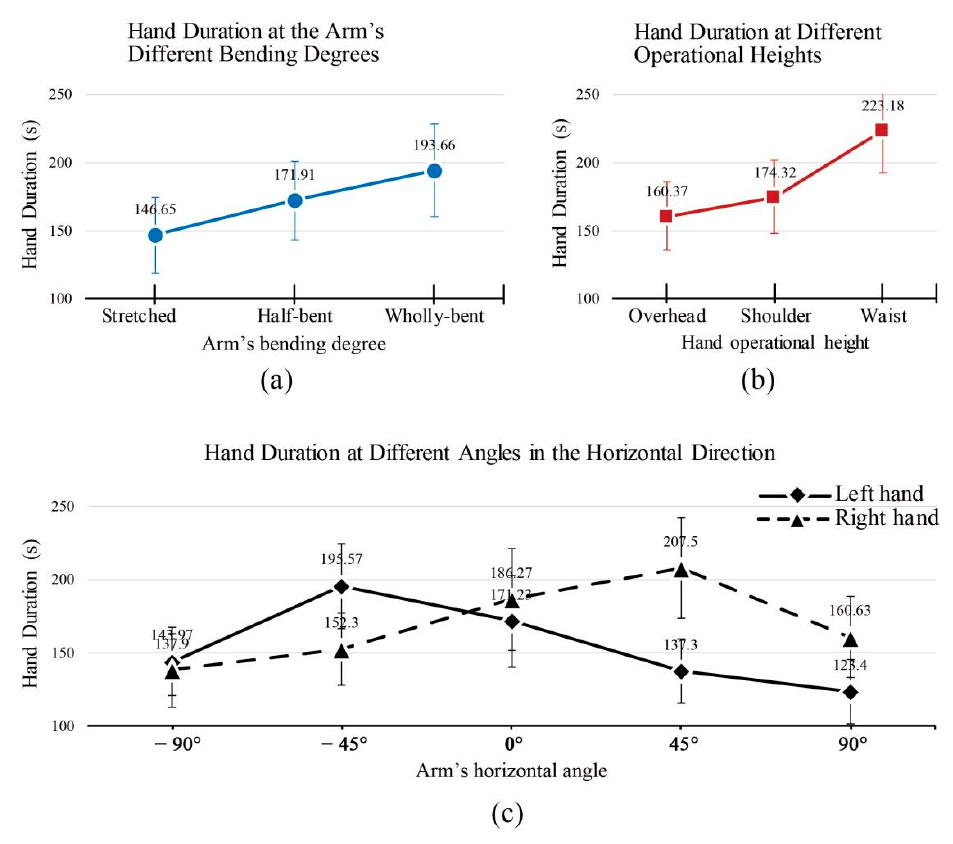
Figure 10. Hand duration comparisons in different conditions: ( a ) result at different bending degrees of the arm; ( b ) result at different hand-operational height; and ( c ) result at different horizontal angles.